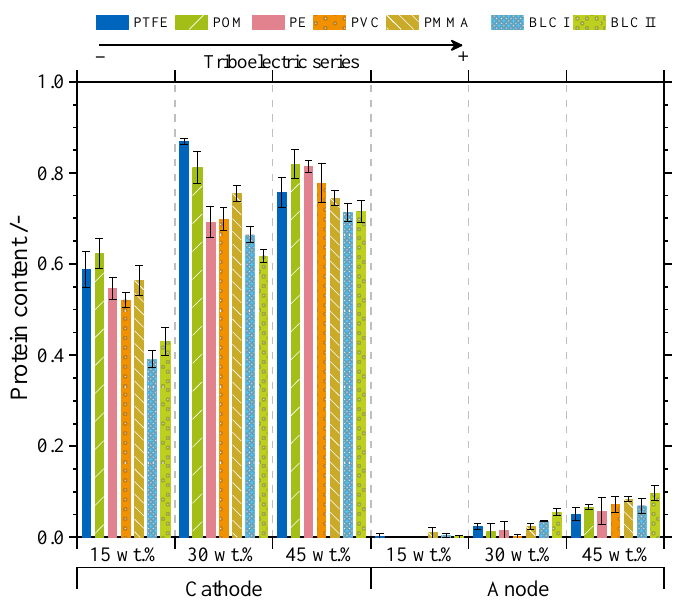
Figure 4. Protein content on the cathode and anode of powders with an initial protein content of 15 wt.%, 30 wt.% and 45 wt.%. Bars indicate different contact materials along with the triboelectric series and setup without wall interaction (BLC I & II). An increase in initial protein content leads to a significant increase in protein content on the cathode and anode. Different contact materials do not affect the protein content on each electrode. Results for 15 wt.% were taken from a previous study [36].